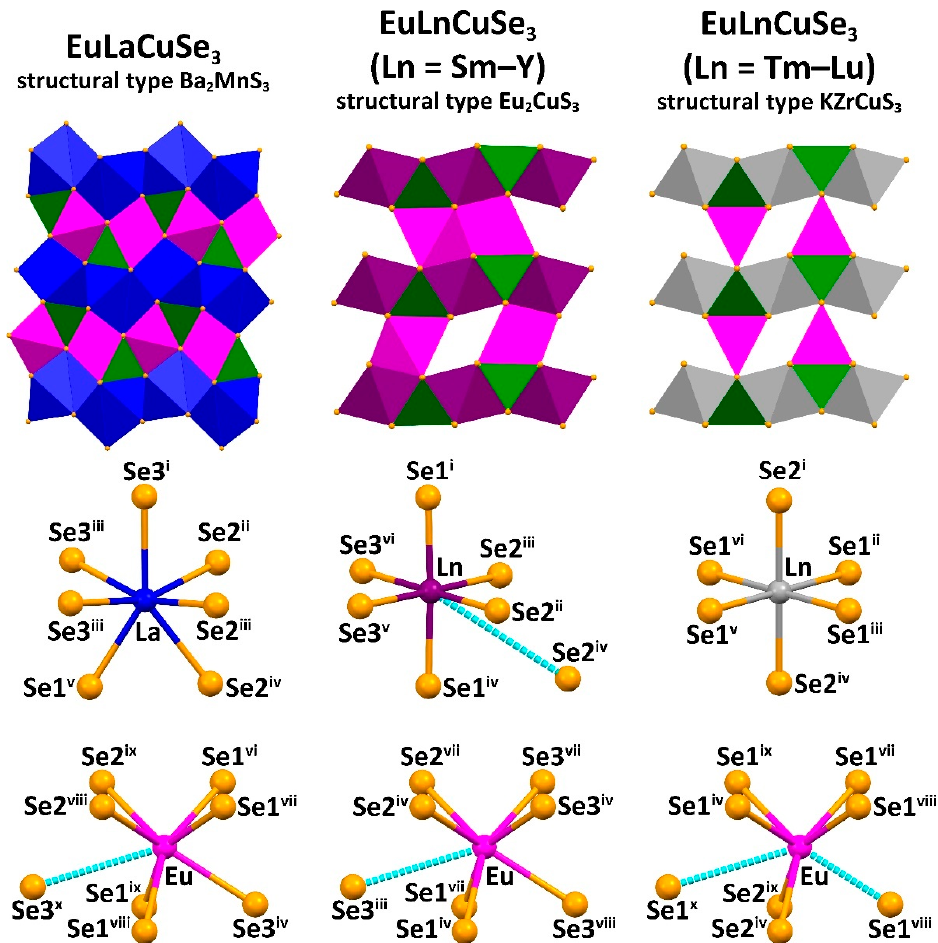
Figure 1. Best views of the crystal structures of EuLaCuSe 3 , EuLnCuSe 3 (Ln = Sm–Y) and EuLnCuSe 3 (Ln = Tm–Lu) (top row). Coordination environments around the Ln 3+ (middle row) and Eu 2+ (bottom row) cations in the structures of the reported selenides. For bond distances, see Table S4 in the Supplementary Materials. Color code: magenta polyhedron = EuSe 7 for EuLnCuSe 3 (Ln = La–Y) and EuS 6 for EuLnCuSe 3 (Ln = Tm–Lu), green polyhedron = CuS 4 , blue polyhedron = LaSe 7 , purple polyhedron = LnSe 6 (Ln = Sm–Y) and grey polyhedron = LnSe 6 (Ln = Tm–Lu).